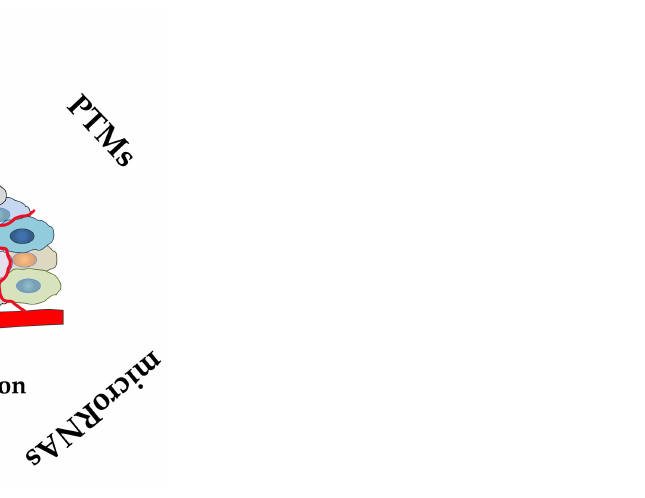
Figure 3. Regulation of ZEB family in cancer progression. PTMs, EMT, miRNA and immune checkpoints of ZEBs functionally are linked to cancer